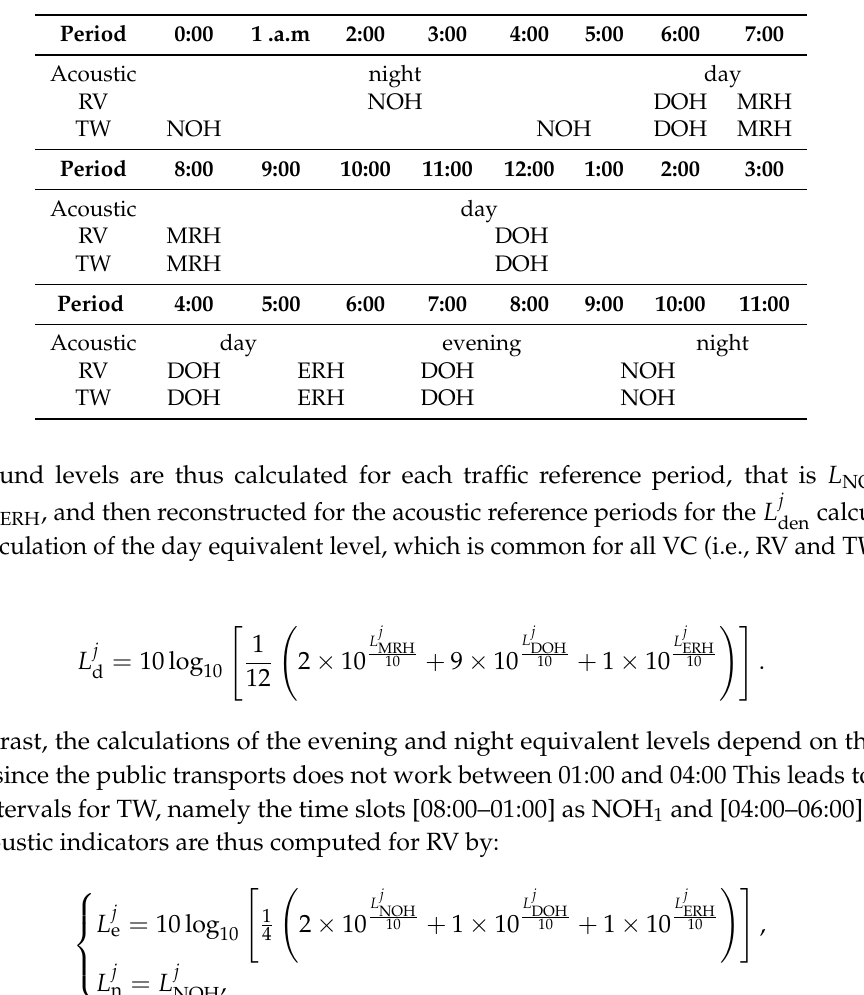
Table 8. Breakdown of “acoustic” reference periods from “traffic” reference